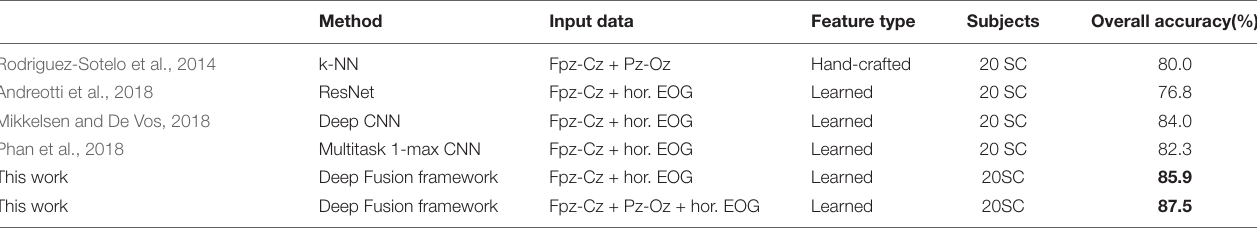
TABLE 7 | Comparison of different methods in classification of sleep stages.